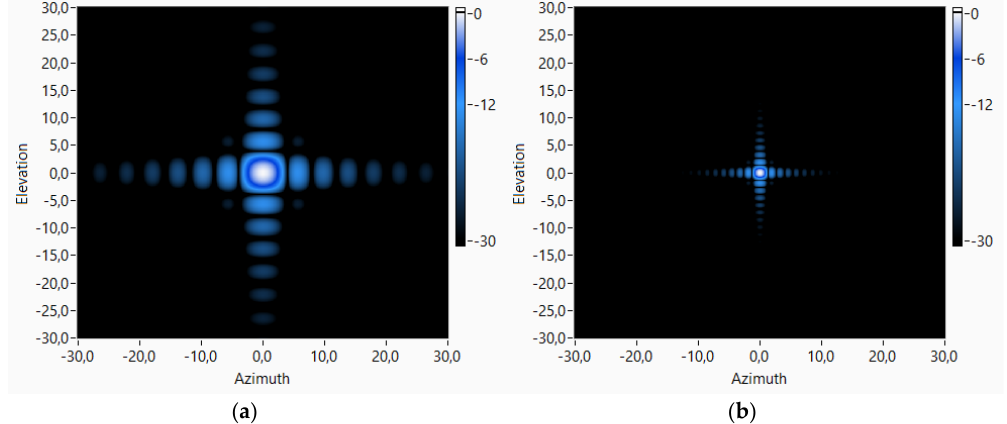
Figure 6. The 80 × 80 array theoretical beam pattern, pointing to (0°, 0°) direction, for working